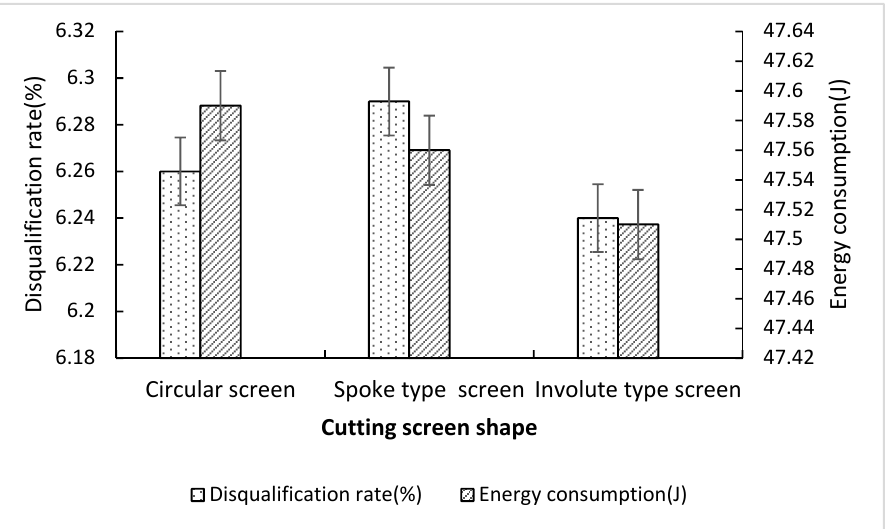
Figure 9. Experimental results of the influence of the cutter head cutting screen shape on the qualification rate and energy consumption of straw crushing.